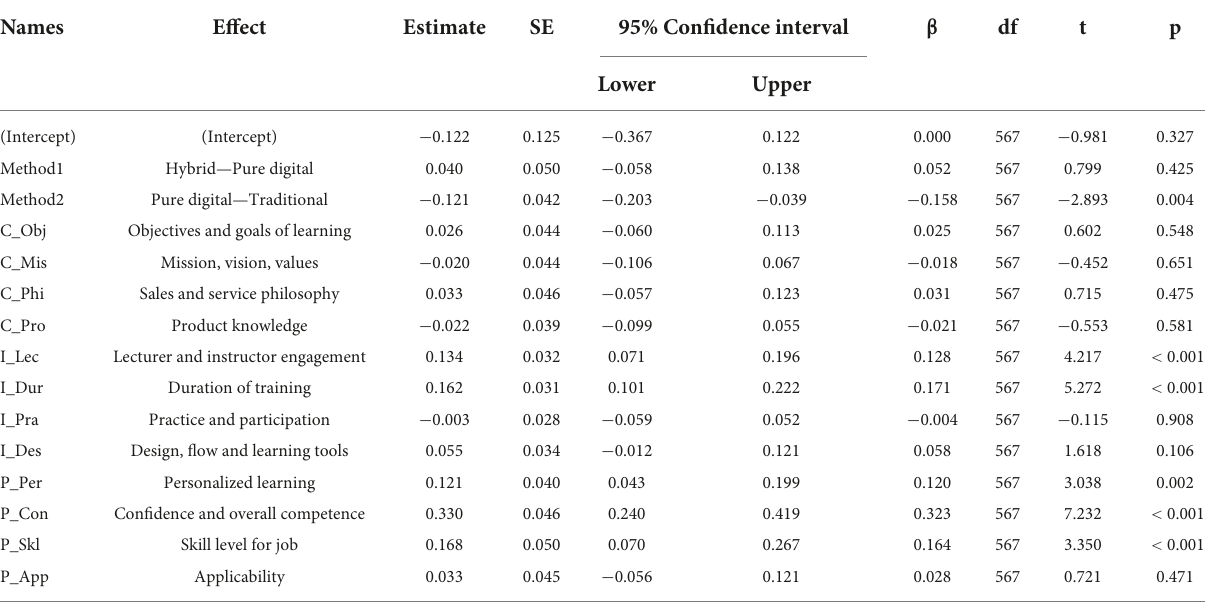
TABLE 9 Fixed-effects parameter estimates.